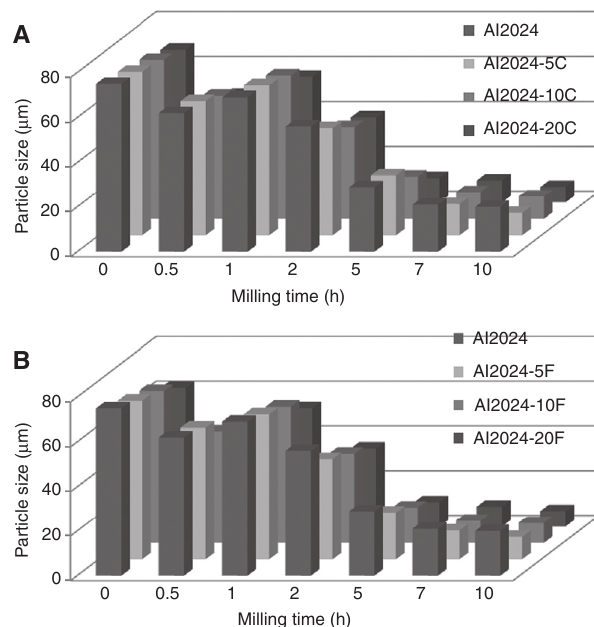
C content on the average 4 C , (B) Al2024-B C 4 Coarse 4 Fine